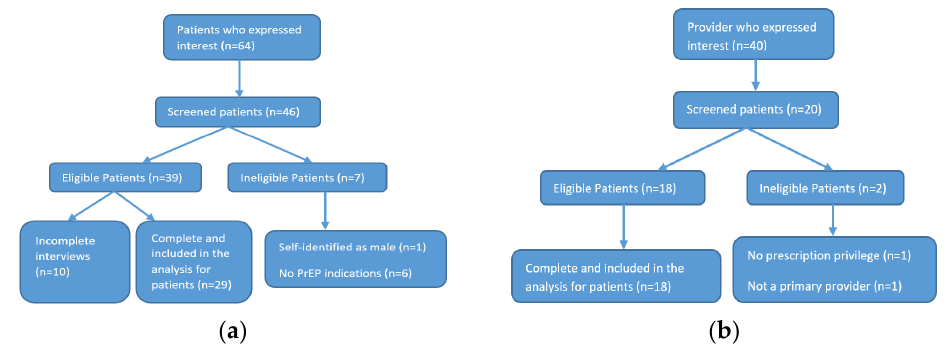
Figure 1. Flowchart for participants enrollment: ( a ) Flowchart for patients enrollment; ( b ) flowchart for providers enrollment.